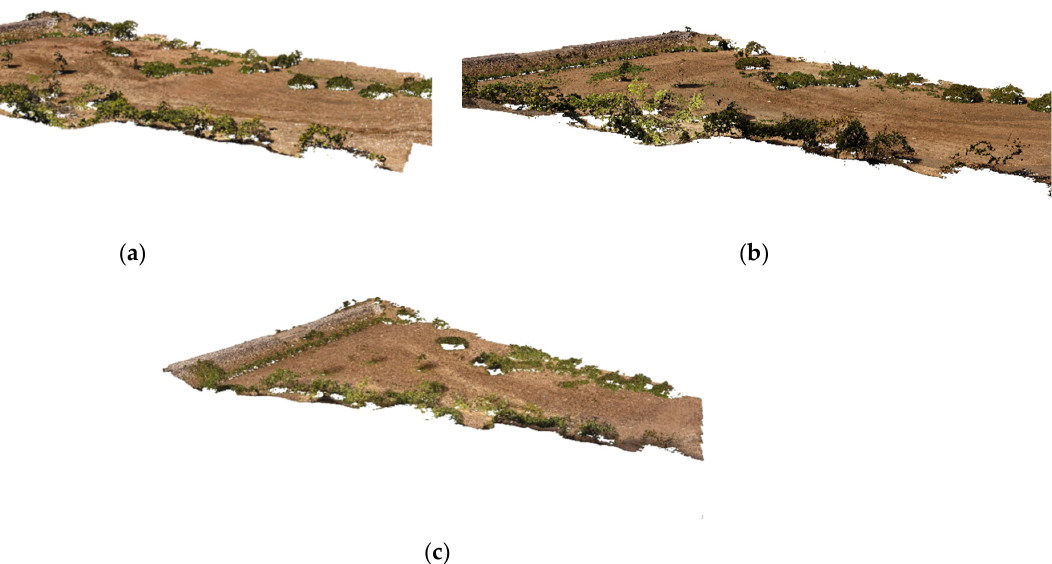
Figure 3. GCP locations on the three acquired orthomosaic images on ( a ) 28 August 2020; ( b ) 16 September 2021; ( c ) 13 October 2022. The numbering refers to the GCP location.